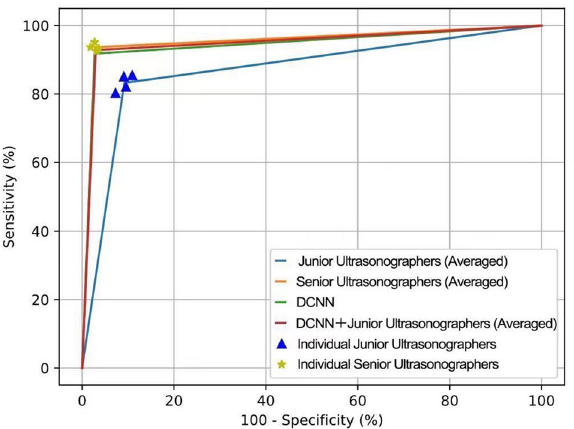
Figure 5. Receiver operating characteristic curves (ROC) show the diagnostic performance in uterine fibroids of the DCNN model, ultrasonographers with different seniority levels and junior ultrasonographers assisted by the DCNN model in the external validation dataset. The ROC curves for Junior ultrasonographers (Averaged) (blue), Senior ultrasonographers (Averaged) (orange), the DCNN model (green), and the DCNN + Junior ultrasonographers (Averaged) (red) provide corresponding AUCs of 0.87 (95% CI 0.84–0.91), 0.95 (95% CI 0.84–0.91), 0.95 (95% CI 0.92–0.97) and 0.95 (95% CI